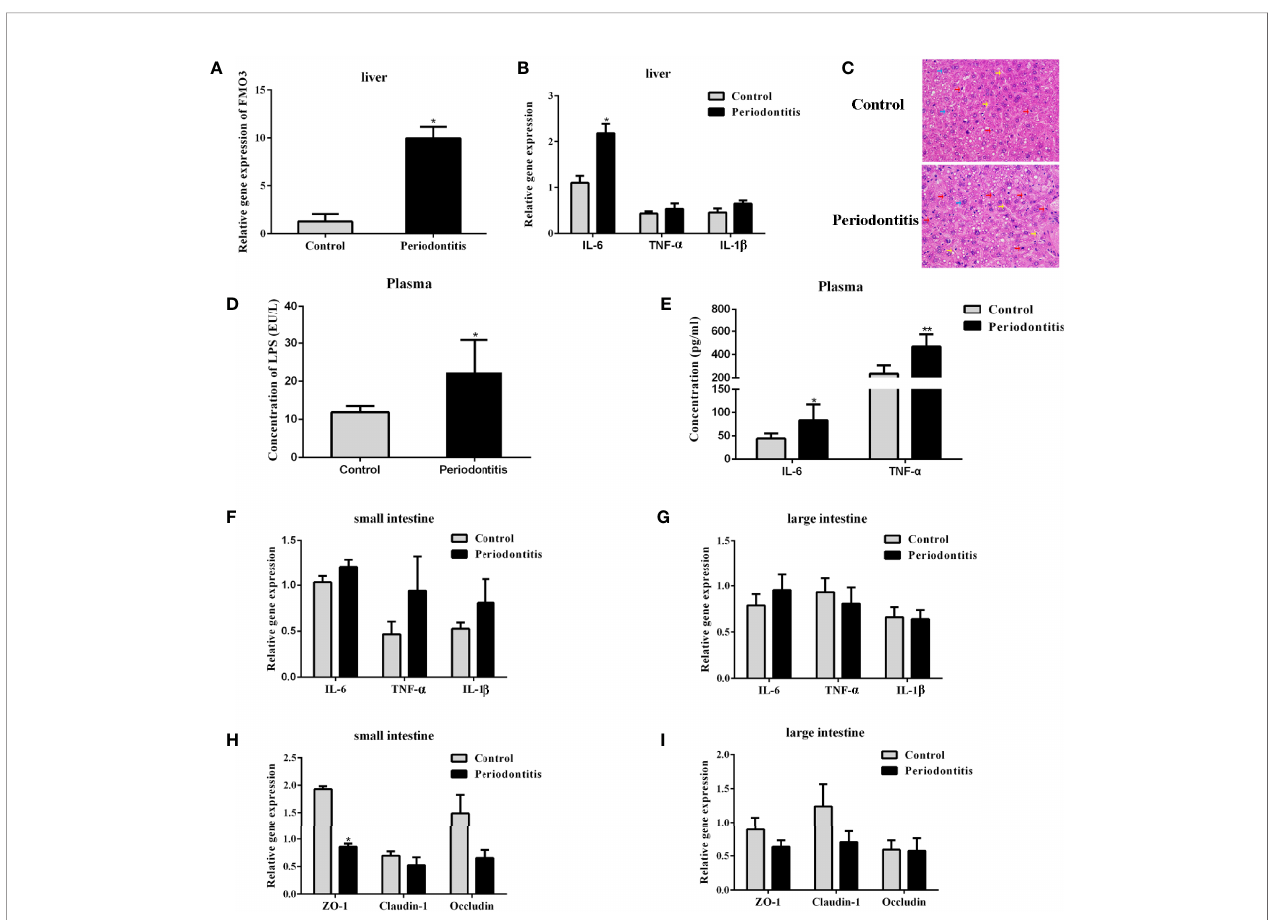
FIGURE 3 | Comparisons of lipopolysaccharide and in fl ammatory factor concentrations in the plasma, liver, and intestine and the expressions of FMO3 and tight junction protein between the control group and the periodontitis group. (A) relative gene expression levels of FMO3 in in the liver tissue. (B) Relative gene expression levels of in fl ammatory cytokines in the liver tissue. (C) Effects of experimental periodontitis on histopathological changes of liver hepatocytes stained with H&E (original magni fi cation of 400×). Blue arrows: hepatic cells. Red arrows: lymphocytes. Yellow arrows: sinusoids between the plates of hepatocytes. Black arrows: fat vacuoles. (D) concentration of lipopolysaccharide in the plasma. (E) Concentration of in fl ammatory cytokines in the plasma. (F, G) relative gene expression levels of in fl ammatory cytokines in the small intestine and large intestine. (H, I) Comparisons of relative tight junction gene expression levels in the small intestine and large intestine. Data are presented as mean ± SEM. (n = 5/group). *P <0.05; P <